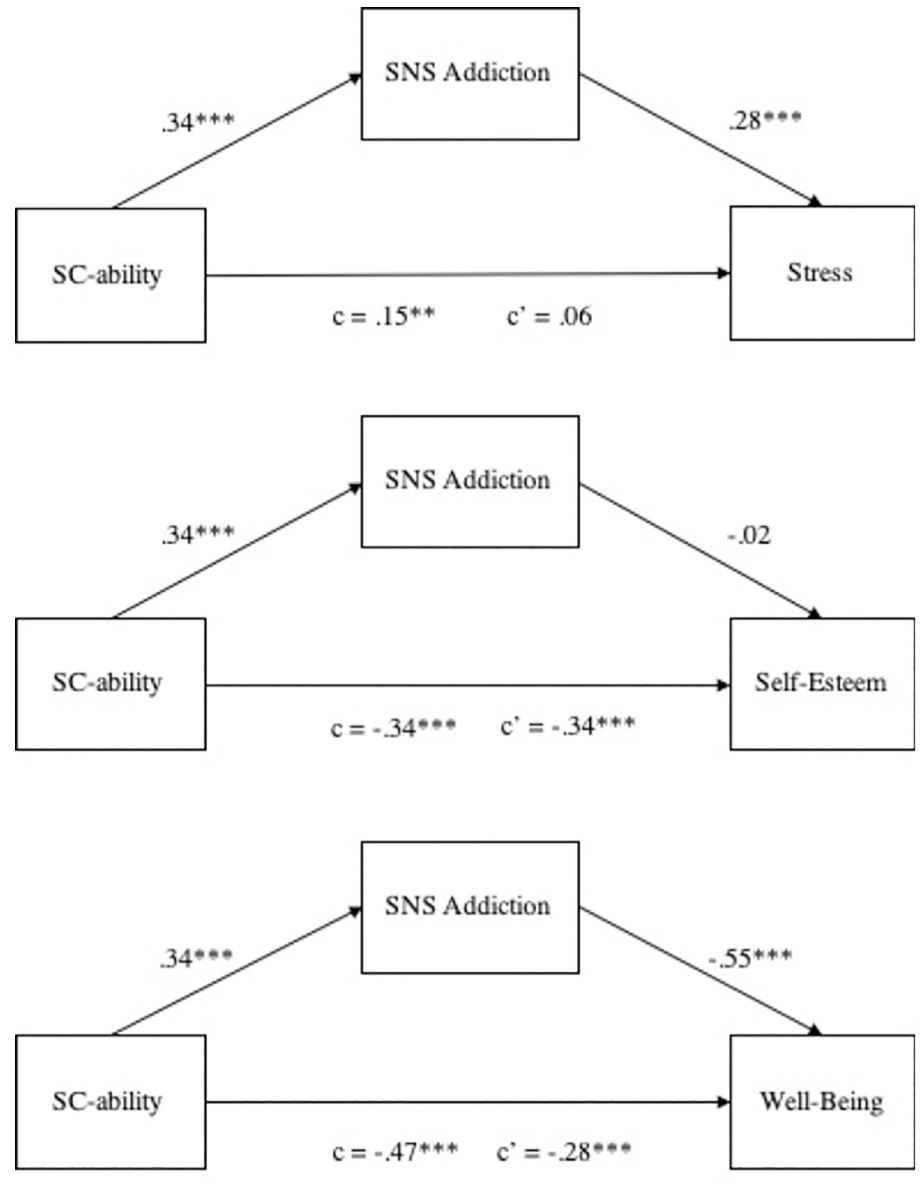
Fig 2. The mediating role of SNS addiction on the relations between social comparison of ability and stress, self- esteem and well-being.